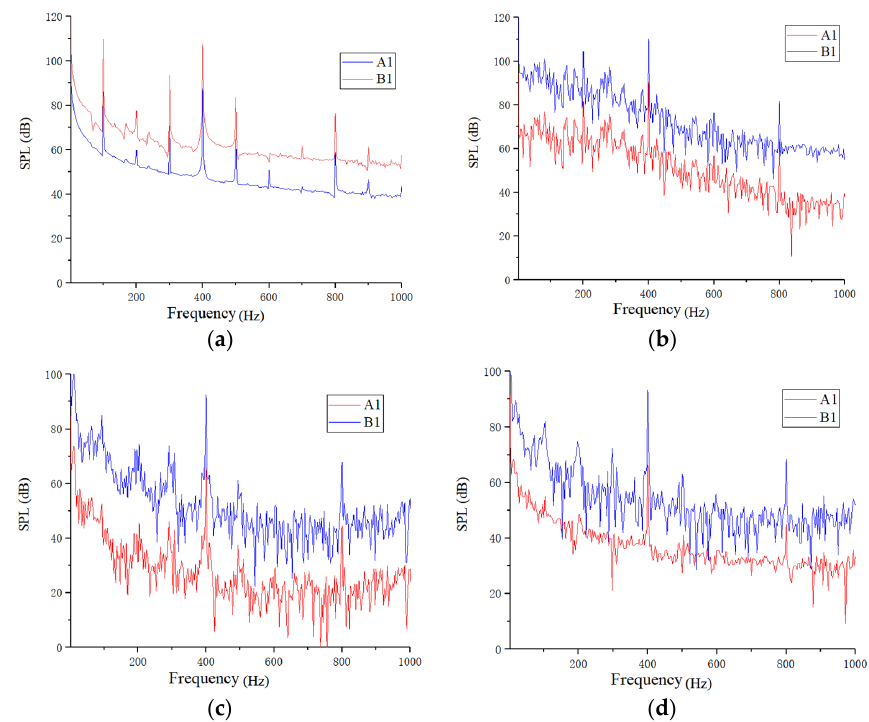
Figure 14. The spectrum diagram of SPL of monitoring point A1 and B1 at different navigational speed. ( a ) 0 m/s; ( b ) 0.37 m/s; ( c ) 1.54 m/s; ( d ) 2.057 m/s.